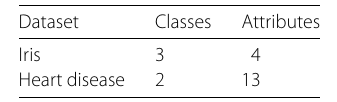
Table 5 Detail of each dataset